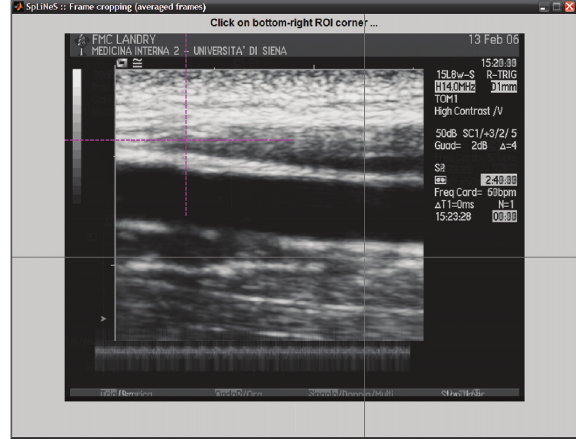
Figure 9: Reference frame: ROI